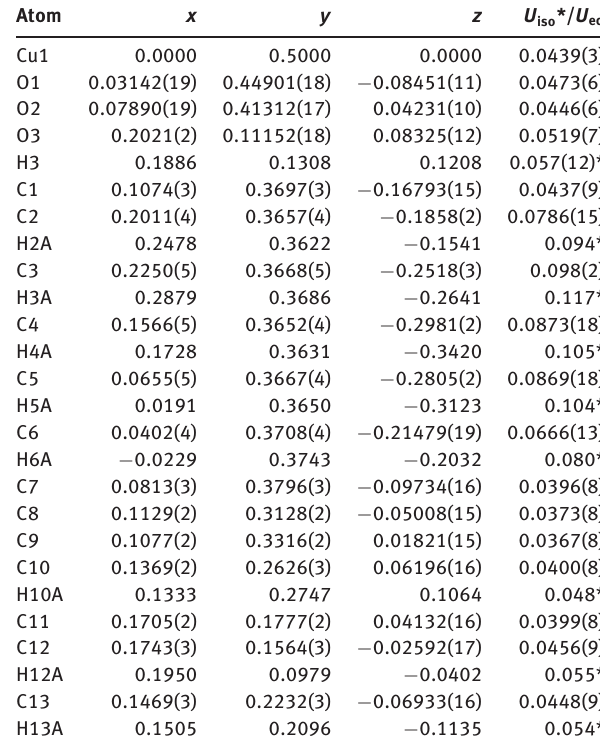
Table 2: Fractional atomic coordinates and isotropic or equivalent isotropic displacement parameters (Å 2